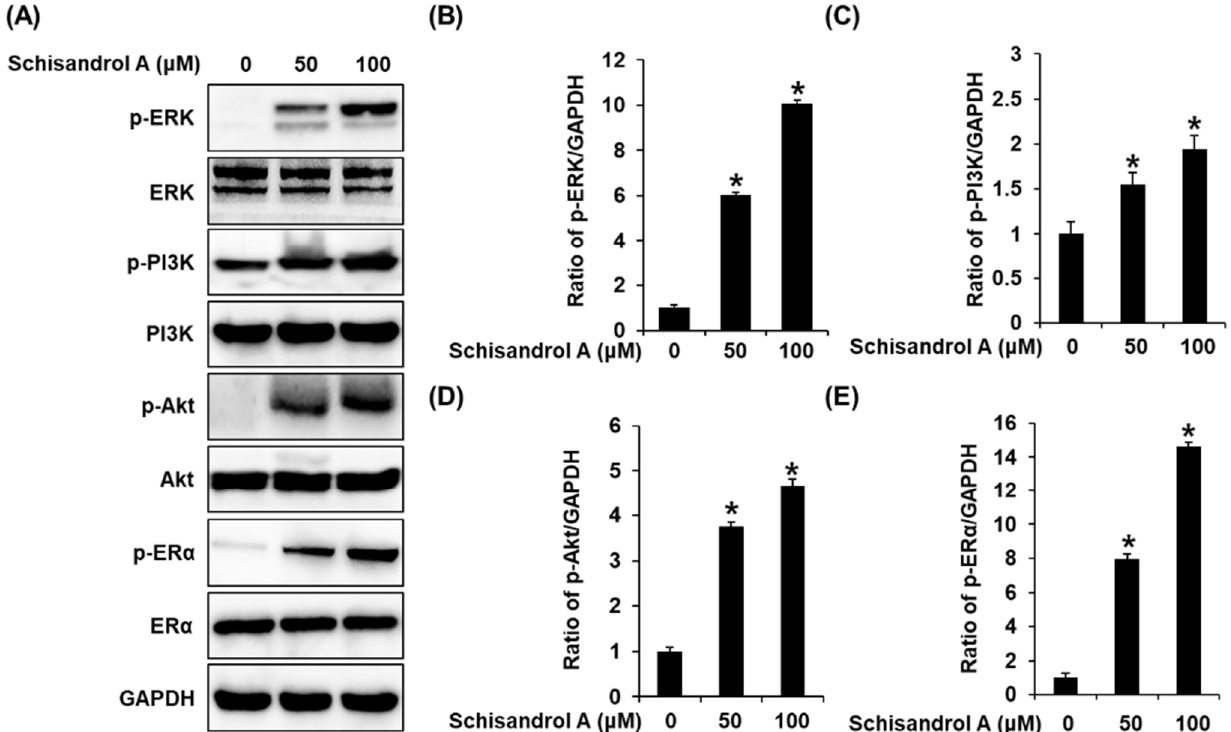
Figure 3. Effect of schisandrol A on the protein expression of phospho-extracellular signal-regulated kinase (p-ERK), ERK, phospho-phosphatidylinositol 3-kinase (p-PI3K), PI3K, p-Akt, Akt, phospho-estrogen receptor α (p-ER α ), and ER α in MCF-7 cells: ( A ) protein expression levels of p-PI3K, PI3K, p-Akt, Akt, p-ER α , and Er α and glyceraldehyde 3-phosphate dehydrogenase (GAPDH) in untreated cells and 50 µM and 100 µM schisandrol A-treated MCF-7 cells (24 h). ( B – E ) Bar graph representing the densitometric quantification of Western blot bands. * Significant difference between cells treated with schisandrol A and the untreated cells ( n = 3 independent experiments, p < 0.05, Kruskal–Wallis nonparametric test). Data are represented as mean ± SEM.